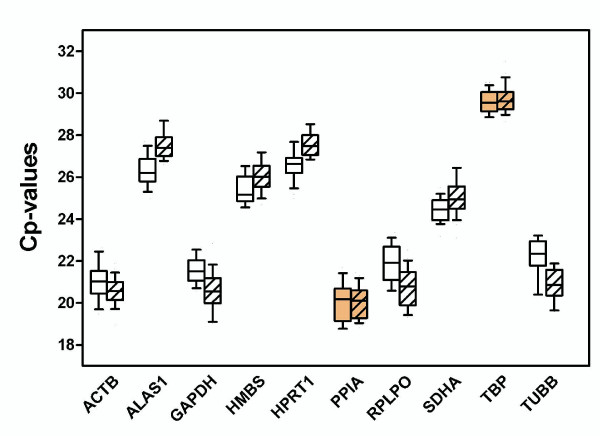
Expression levels of candidate reference genes in non-malignant and malignant renal cell carcinoma samples. Values are given as real-time PCR crossing points (Cp) cycle numbers. Boxes (blank: non-malignant; cross striated: malignant) represent the lower and upper quartiles with medians; whiskers illustrate the 10 to 90 percentiles of the samples. All Cp values except PPIA (P = 0.339) and TBP (P = 0.257) significantly differed between non-malignant and malignant samples (P of 0.0089 to < 0.0001; Wilcoxon test).